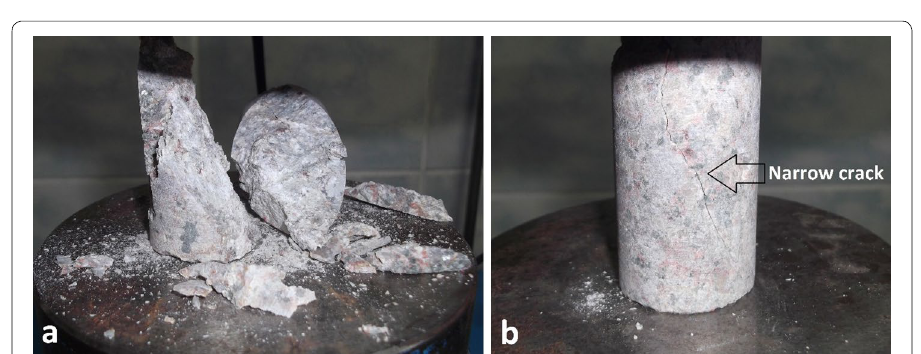
Fig. 11 An example for variation in failure under different strain rates: Limestone specimens tested under different strain rates of